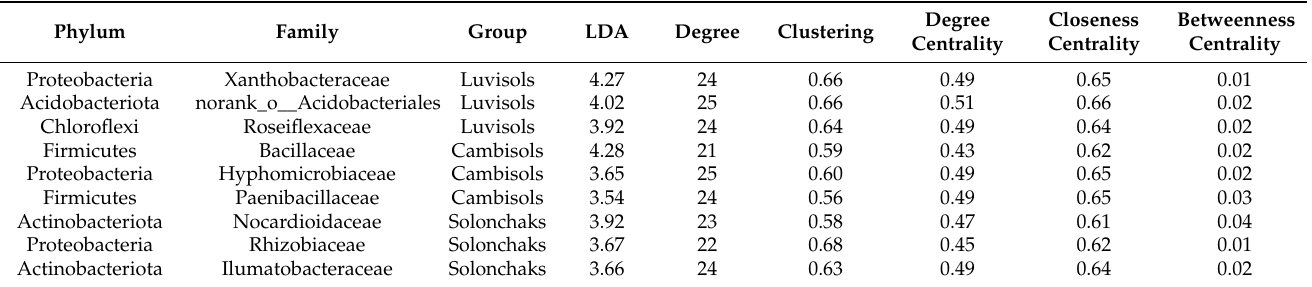
Table 4. Properties of rhizosphere bacterial biomarkers in different soil types of pecan plantations (corresponding to Figures 3 and 4.).